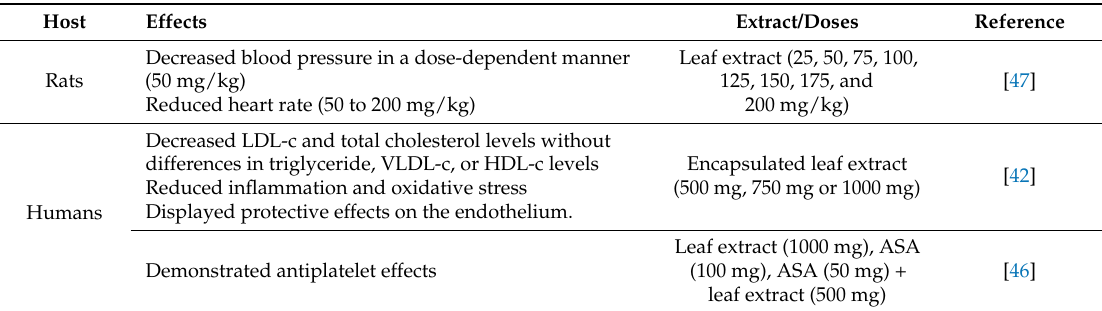
Decreased LDL-c and total cholesterol levels without differences in triglyceride, VLDL-c, or HDL-c levels Reduced inflammation and oxidative stress Displayed protective effects on the